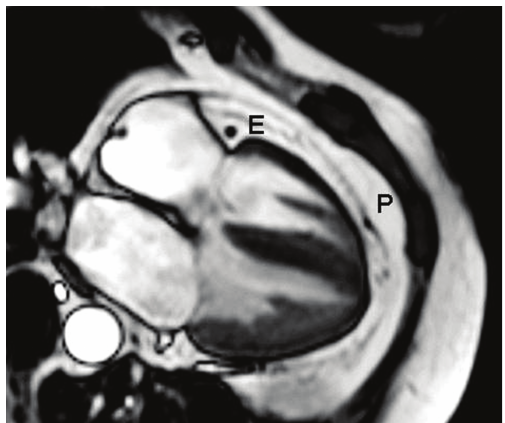
Figure 3: Four-chamber view of the heart. Four-chamber view of the heart where the signal from blood and muscle are suppressed. E: epicardial fat; P: pericardial